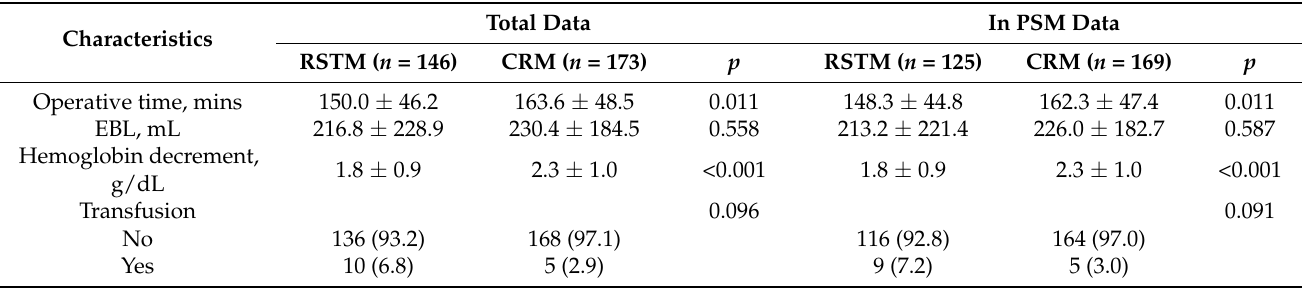
Table 3. Surgical outcomes and morbidity before and after propensity score matching